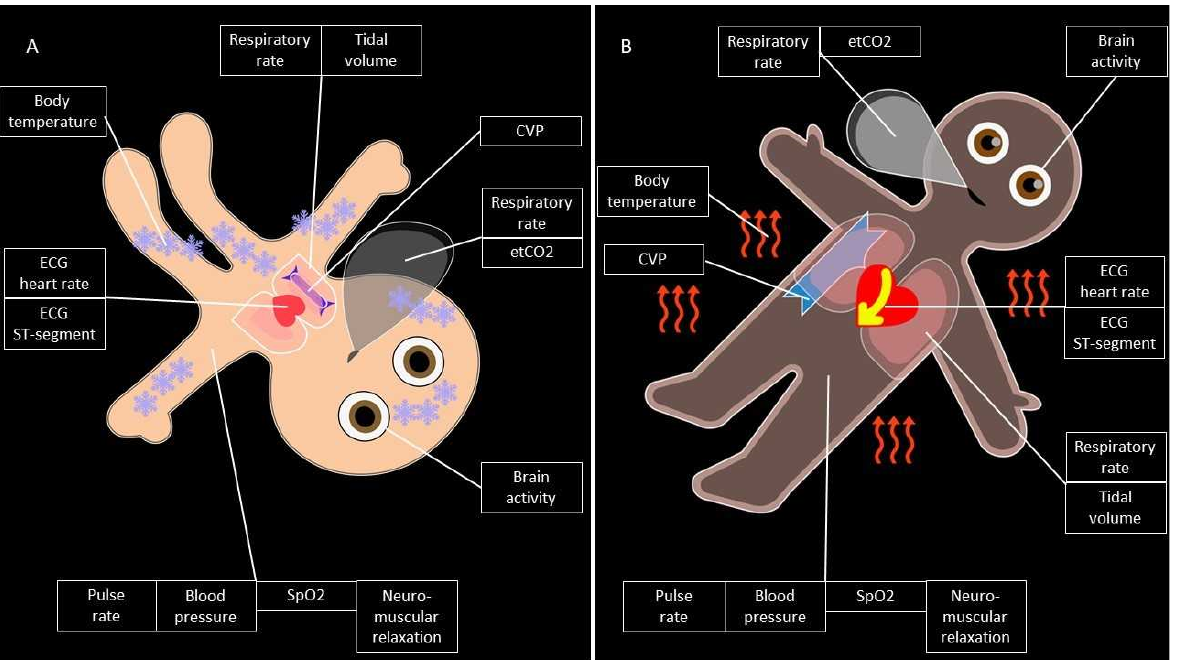
Figure 3. The Visual-Patient-avatar before ( A ) and after ( B ) the redesign process. CVP: central venous pressure, ECG: electrocardiogram, etCO2: end-tidal carbon dioxide, SpO2: peripheral oxygen saturation. When the body temperature is within the normal range, neither ice crystals nor heatwaves are visible.